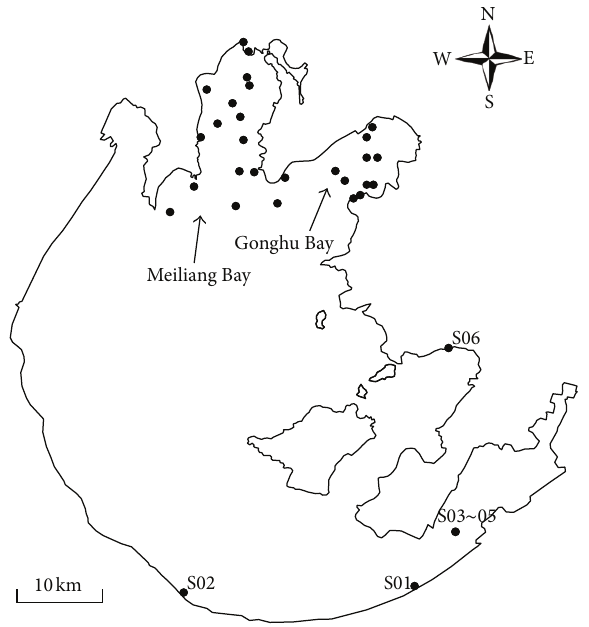
Figure 1: Map showing sampling locations on Lake